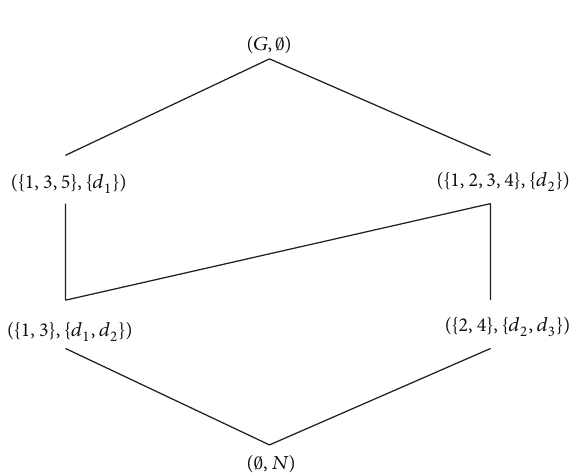
Figure 2: The Hasse diagram of B 𝐹 (𝐺, 𝑁,𝐽)